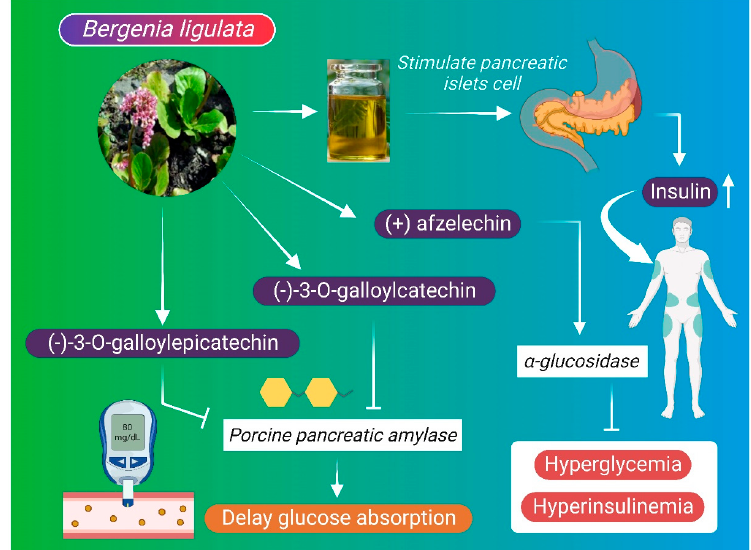
Figure 5. Anti-diabetic mechanism of B. ligulata . Plant extract stimulates the pancreatic islet cells and increases insulin secretion for maintaining normal blood glucose levels. (+) afzelechin, a compound of B. ligulata , inhibits the enzymatic action of alpha-glucosidase, thus delaying the absorption of dietary carbohydrate in the small intestine and reduces postprandial hyperglycemia and hyper- insulinemia. Additionally, compounds such as (-)-3-O-galloylepicatechin and (-)-3-O-galloylcatechin from B. ligulata inhibit pancreatic α -amylase and delay the absorption of glucose in the intestine.